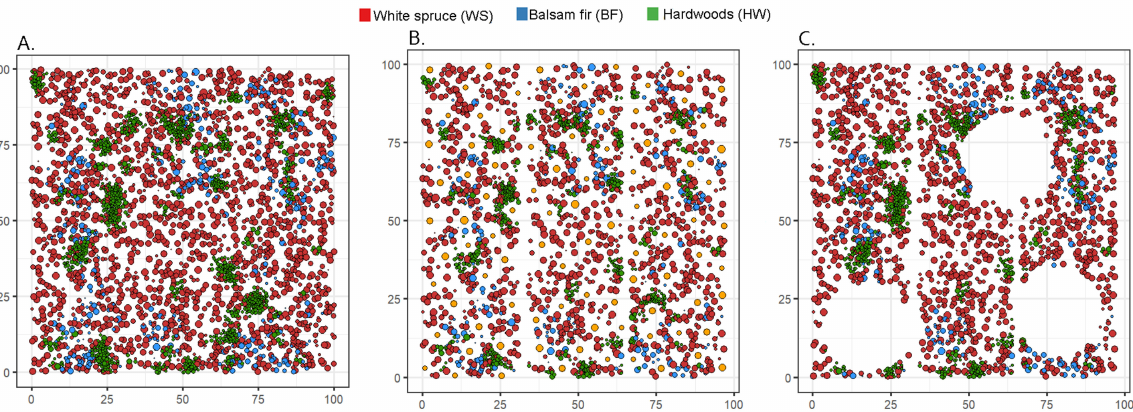
Figure 5. Example of simulations on a 1-hectare area for ( A ) initial spatial stand structure; ( B ) TrT CT : 80 crop trees (orange dots) selected per hectare, with a 3 m thinning radius over all sides; and ( C ) gap creation (3 gaps; cut area: 30% of the total). The vertical spaces visible on plots ( B , C ) are skidding trails, which essential for commercial thinning